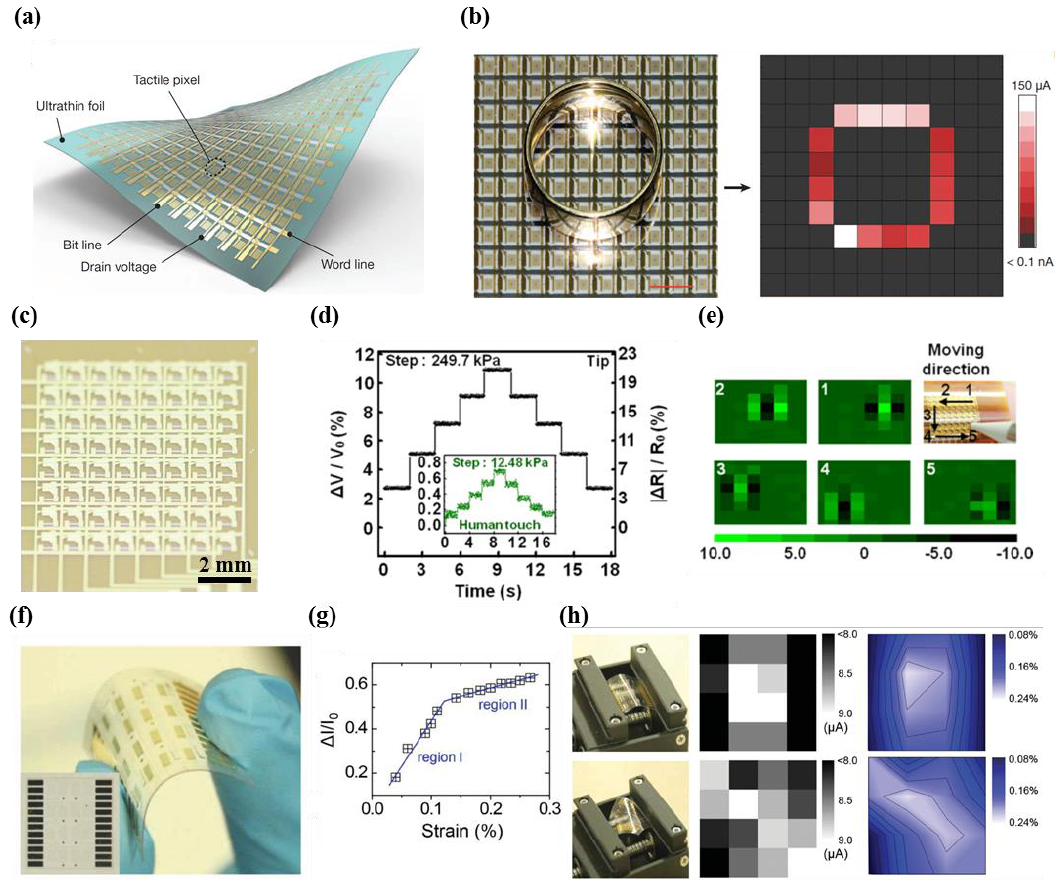
Figure 4. ( a ) Illustration of the tactile sensor array with active matrix circuitry; ( b ) photographic image showing the tactile sensor array (left). The mapping data by pressure of the ring (right) (reprinted with permission for Figure 4a,b from Ref. [49] Copyright 2013 Springer Nature); ( c ) photograph of silicon membrane tactile sensor with active matrix circuitry; ( d ) real-time monitoring of the fractional change in voltage versus the pressure levels in real time; ( e ) data and image showing the movement of stylus tip (reprinted with permission for Figure 4c–e from Ref. [51] Copyright 2015 AIP Publishing); ( f ) photograph showing active matrix array sensor based on the graphene; ( g ) sensitivity performance of graphene transistor (GT) strain sensor including region I and II; ( h ) the image and output data under different bending states (left) (reprinted with permission for Figure 4f–h from Ref. [54] Copyright 2015 John Wiley and Sons).